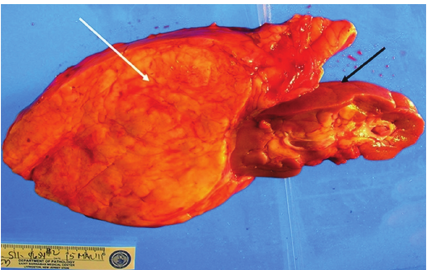
Figure 3: Gross image of the en bloc resected mass including the left kidney (black arrow), demonstrating a well-encapsulated fatty mass attached to the upper pole of the kidney (white arrow), with a smooth outer surface measuring 23 cm × 14 cm × 9 cm. Reproduced from